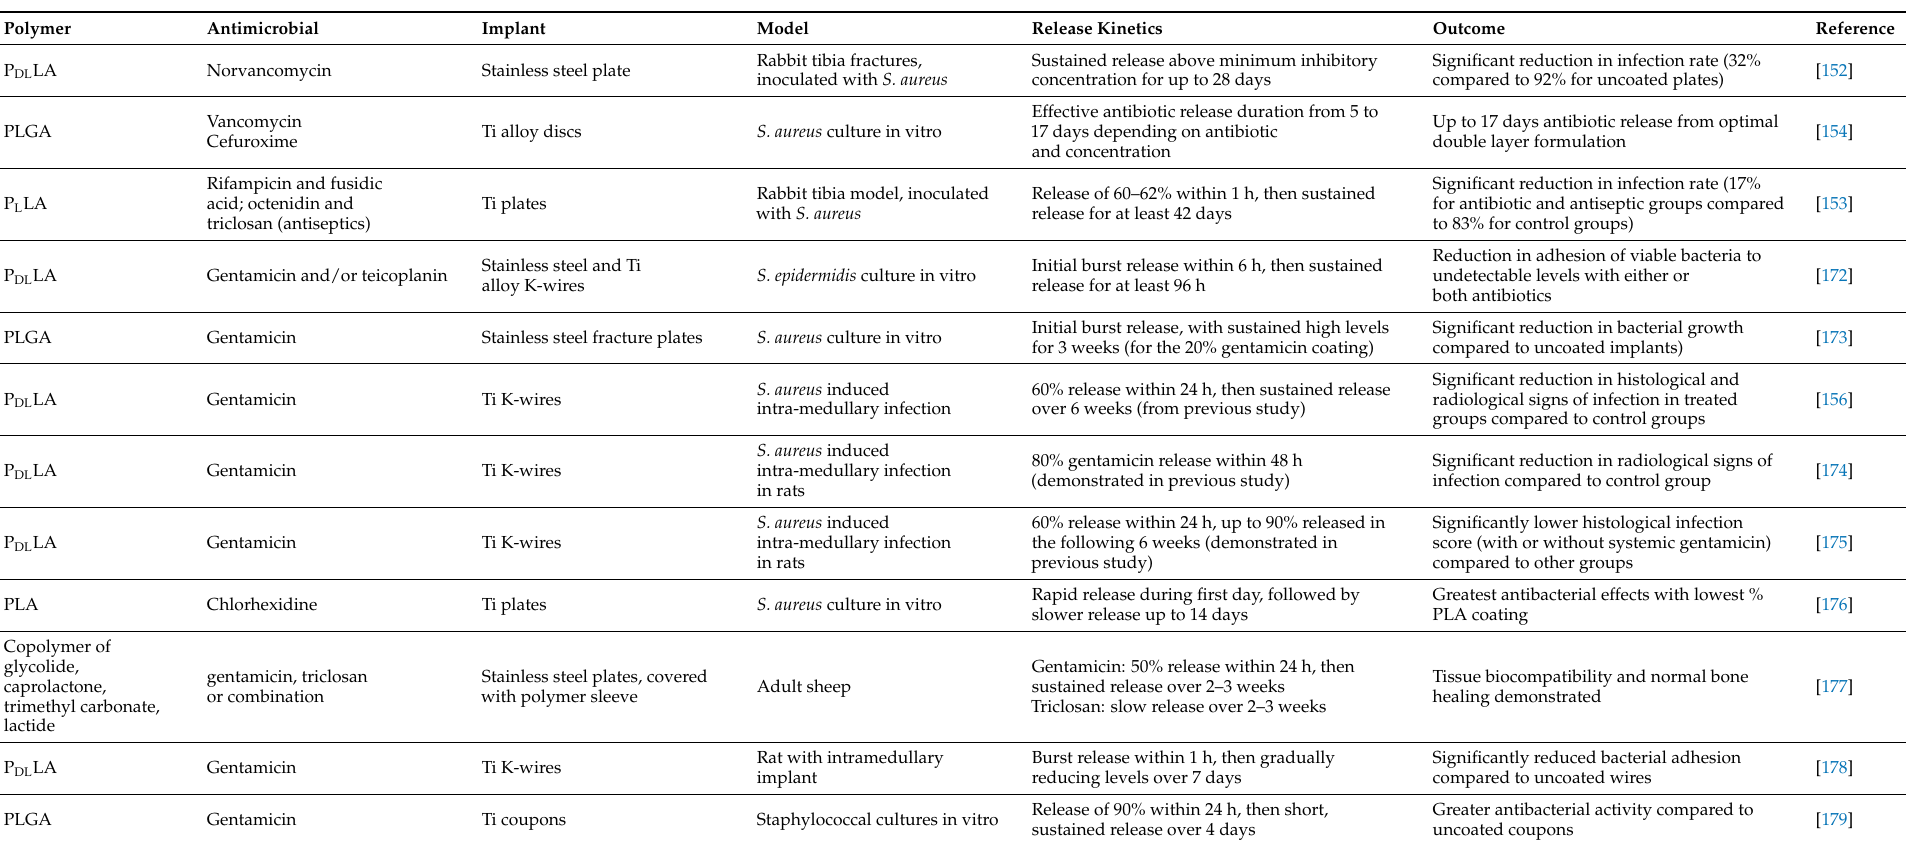
Table 2. Antimicrobial delivery systems based on PLA and PLGA coatings for metal implants. The table highlights polymer type, antibiotic/antiseptic, implant substrate, in vitro or in vivo model, release kinetics and experimental